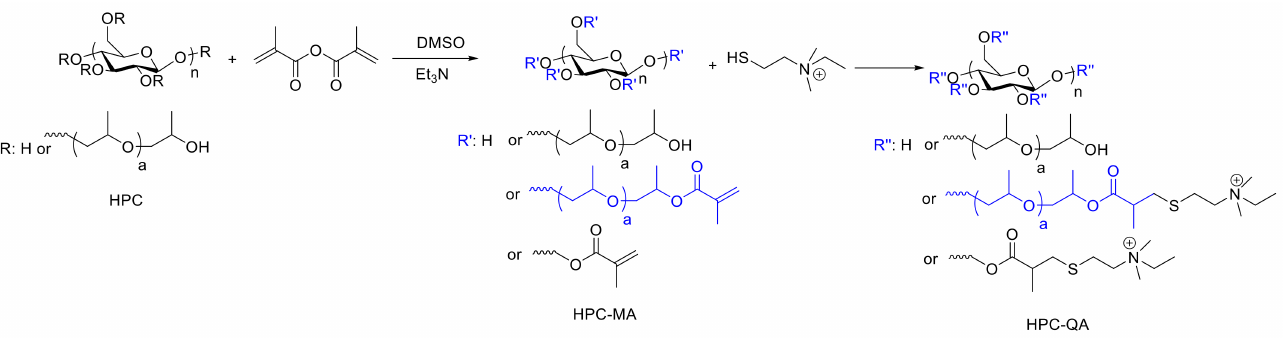
Scheme 2. Synthesis of HPC-MA and